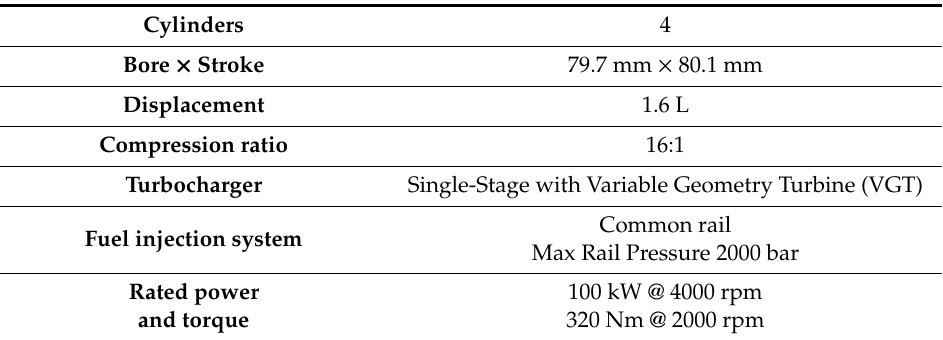
Table 1. Main design characteristics of the test